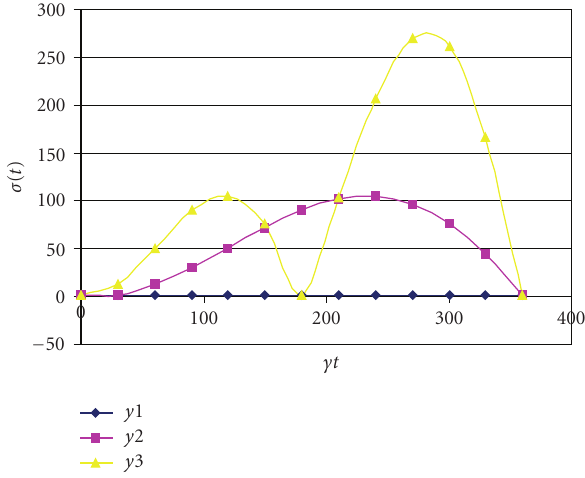
Figure 3: Variation of σ ( t ) with γt for the critical damped oscillator with various damping factors of 0, 0.5 Ω , and Ω